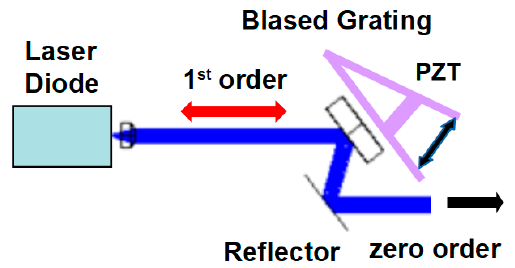
Figure 2. Configuration of the tunable master oscillator.